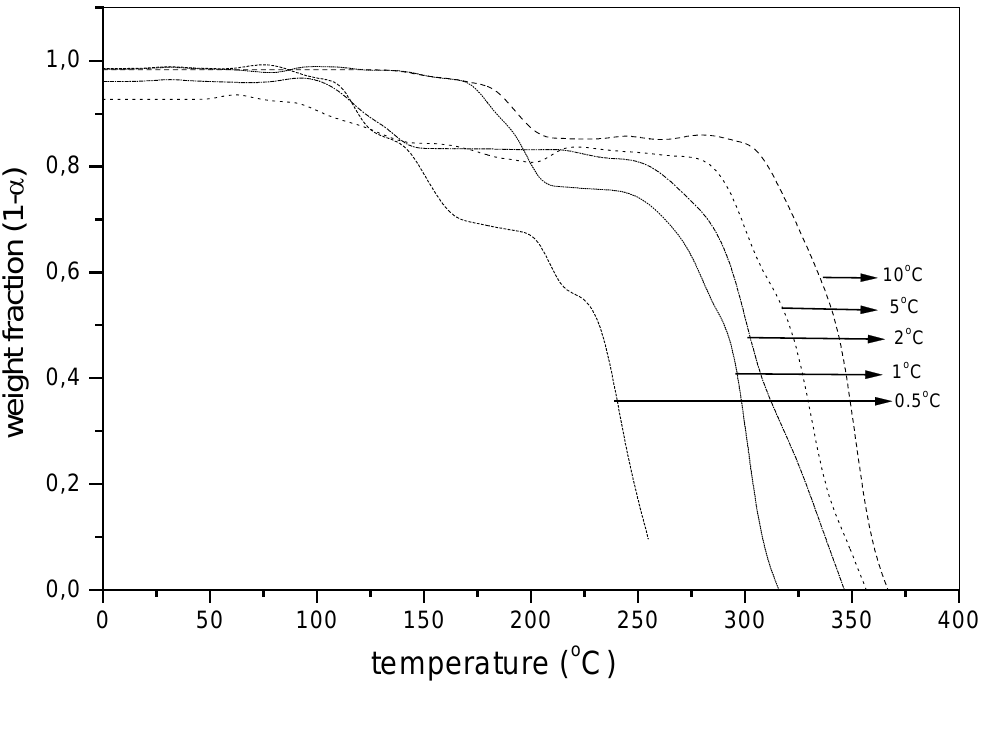
Figure 3 . The weight fraction (1- α ) of the sample aqPUR2 with the MnCAT (2%) depending on the temperature during the dynamic thermooxidation, at different heating